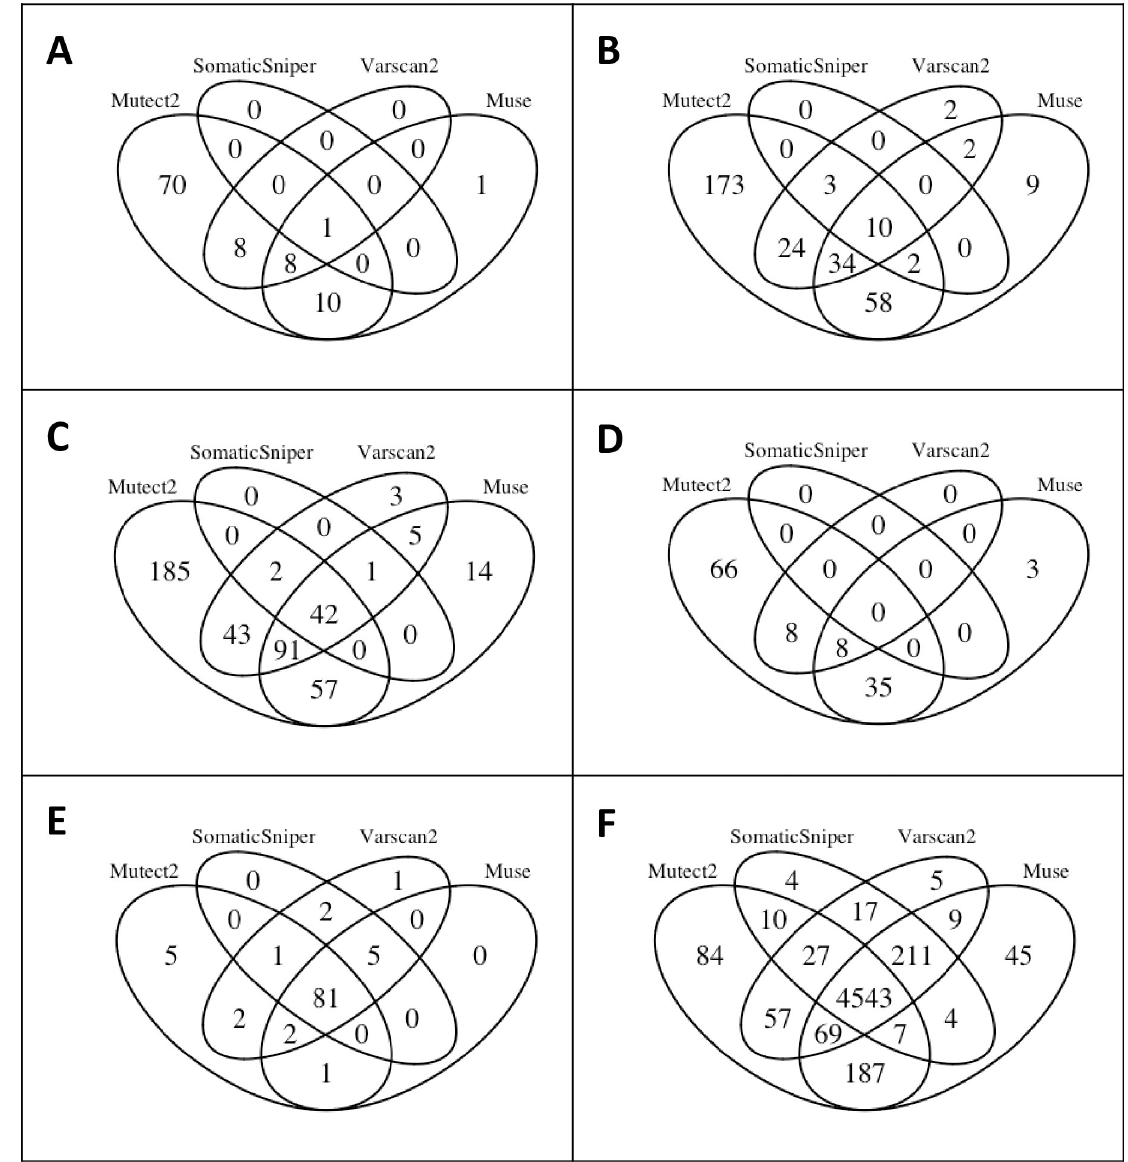
Fig 3. Visualization of the overlap in mutation calling between the four pipelines (Muse, Mutect2, SomaticSniper, Varscan2) mutation calling pipelines in four cases with high CV (a-d), and two cases with low CV. Sample details are: (A) TCGA-XF-A9SL-01A-11D-A391-08, CV = 1.3, 35 mean / 100 total mutation calls; (B) TCGA-K4-A83P-01A-11D-A34U-08, CV = 0.98, 125 mean /317 total mutation calls; (C) TCGA-XF-A9SI-01A-11D-A391-08, CV = 0.71, 215 mean / 450 total mutation calls; (D) TCGA-DK-A1AF-01A-11D-A13W-08, CV = 1.00, 45 mean / 120 total mutation calls; (E) TCGA-LT-A8JT-01A-11D-A364-08, CV = 0.026, 90 mean / 100 total mutation calls; (F) TCGA-DK-A6AW-01A-11D-A30E-08, CV = 0.020, 5000 mean / 5300 total mutation calls.